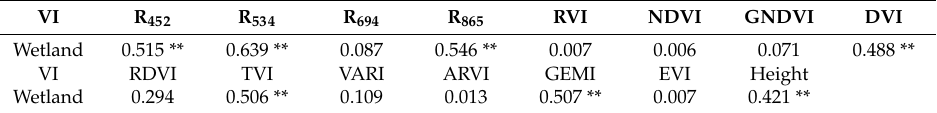
Table 1. Correlation coefficients between wetland vegetation biomass and spectral parameter.